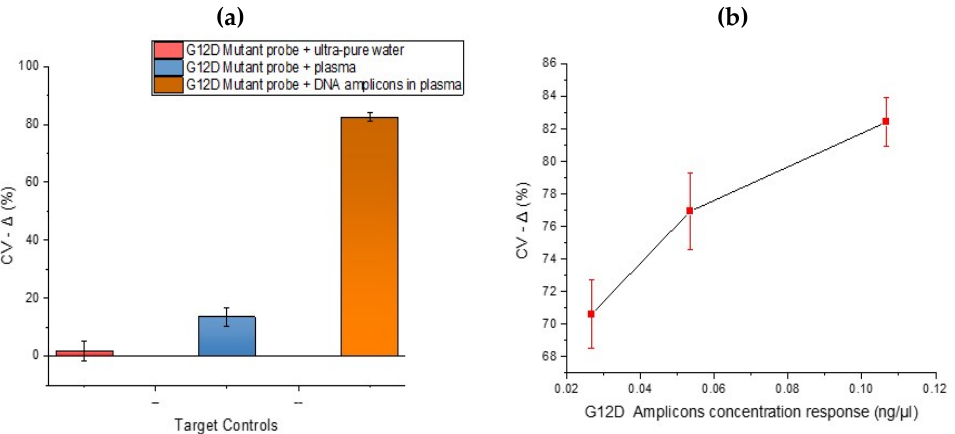
Figure 6. ( a ) CV results showing DNA hybridisation target controls using (i) G12D mutant probe in ultrapure water (ii) G12D mutant probe in human plasma (iii) G12D mutant probe in representative sample containing KRAS G12D mutant amplicons in plasma ( b ) CV results (% signal change) showing G12D amplicons concentration dose response.